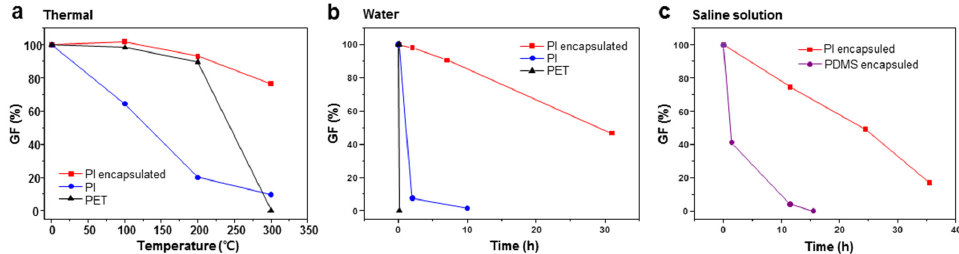
Figure 2. The performance comparison of the crack sensors in different environments. ( a ) Performances of the sensors after thermal treatment; ( b ) Performances of the sensors after dipping in water; ( c ) Performances of the sensors dipping in saline solution (0.9% NaCl). PET: polyethylene terephthalate; PDMS: polydimethylsiloxane.